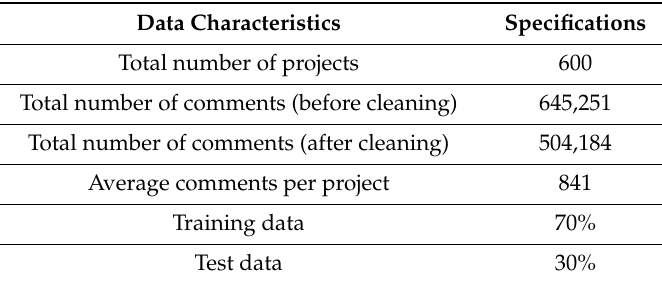
Table 1. Input data